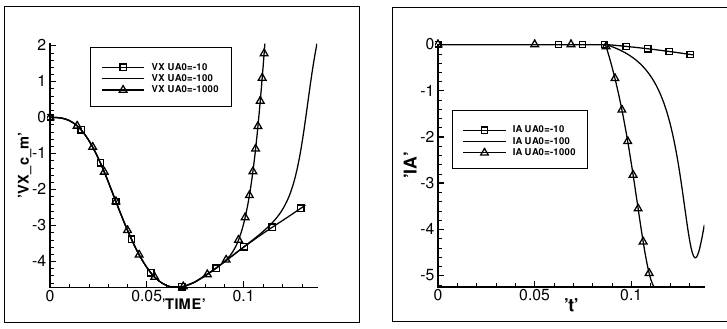
Figure 11. (a) the liner centre of mass velocity; (b) the liner circuit current.